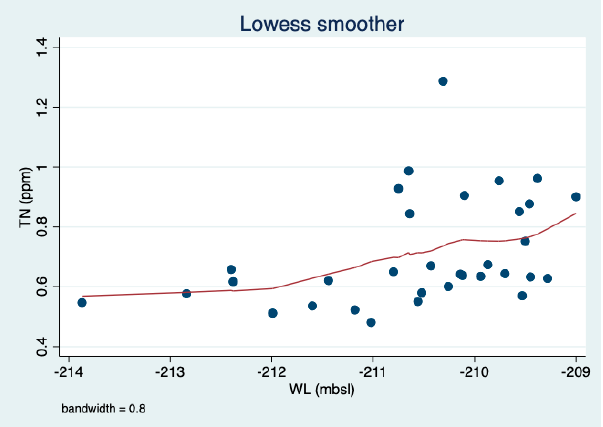
Figure 10. Trend of changes (Lowess smoother, 0.8 bandwidth) of annual lake averages of total nitrogen (TN) concentration (ppm scale range: 0.4–1.4) with respect to WL (mbsl) during 1969–2001.